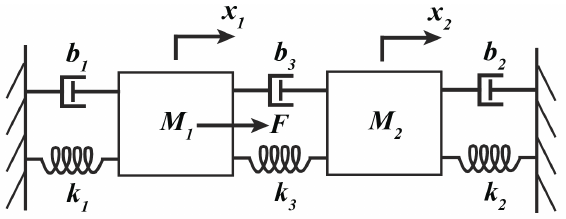
Figure 5. Mass–spring-damper model of the VCA-Stinger-hand unit